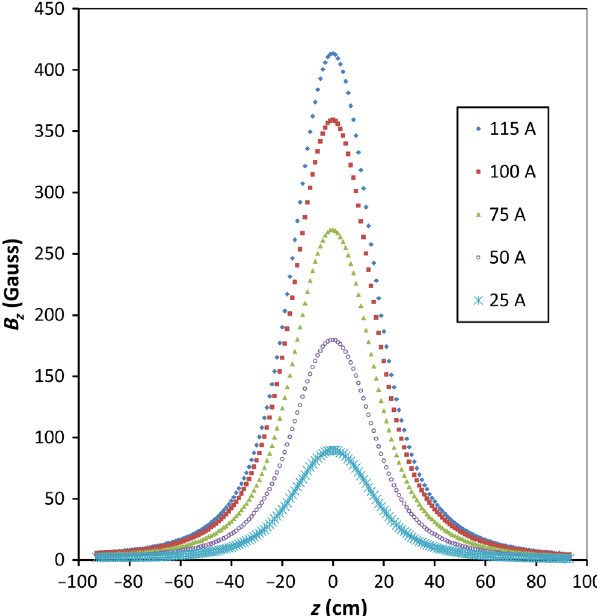
FIG. 3. Magnetic bias field on axis of the DML apparatus for differing values of the solenoid drive current, as indicated in the